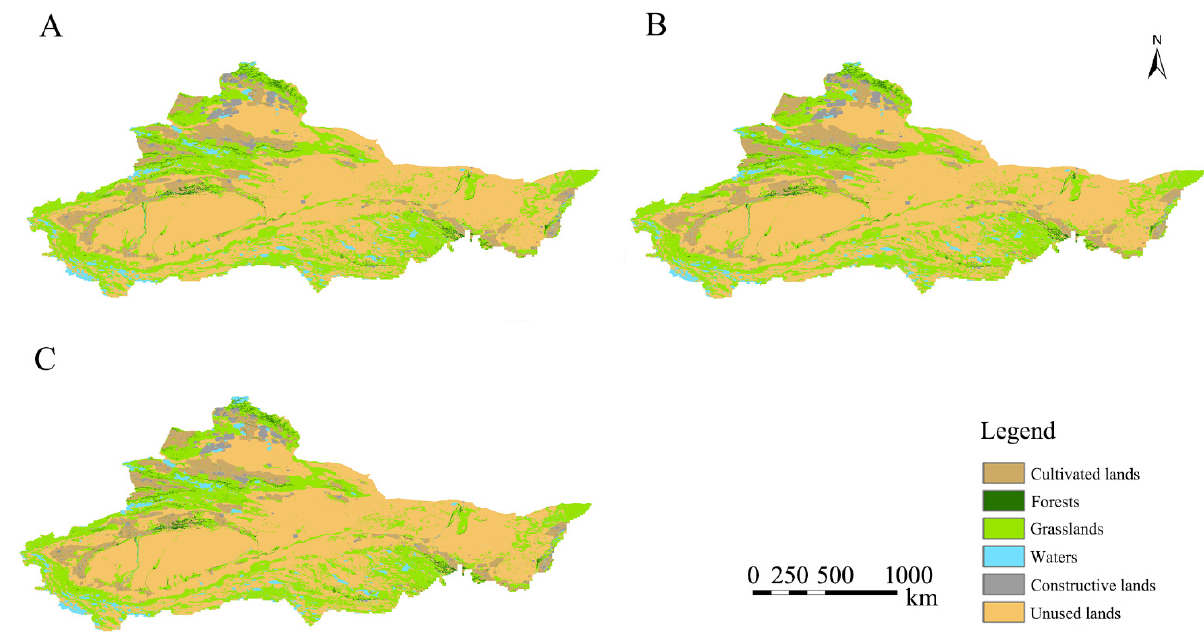
Figure 8. Prediction map of land use in the arid desert region of Northwest China in 2040 under three scenarios: ( A ) the natural development scenario, ( B ) the cultivated land protection scenario, and ( C ) the ecological protection scenario.